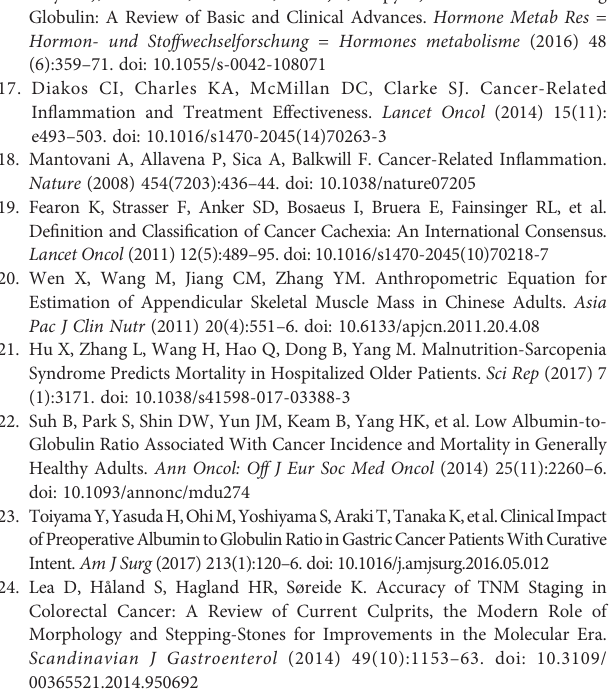
Supplementary Figure 4 | Kaplan-Meier curves of OS for cachexia patients strati fi ed by low- and high-AGR for multiple cancer types in training cohort (including lung cancer, gastric cancer, esophagus cancer, colorectal cancer, hepatic-biliary-pancreatic cancer, gynecological cancer, breast cancer, and other cancer). Supplementary Figure 5 | Strati fi ed analysis of cachexia patients with high AGR and low AGR based on TNM stage. (A) , training cohort, (B) , validation cohort. Supplementary Figure 6 | Comparison of the ability of serum protein in predicting prognosis of cachexia patients using ROC curves. (A) , ROC curve at 3-year OS point in training cohort, (B) , ROC curve at 5-year OS point in training cohort, (C) , ROC curve at 3-year OS point in validation cohort, (D) , ROC curve at 5-year OS point in validation cohort. Supplementary Figure 7 | Combined survival analysis of AGR and covariates interaction. (A) , training cohort, (B) , validation